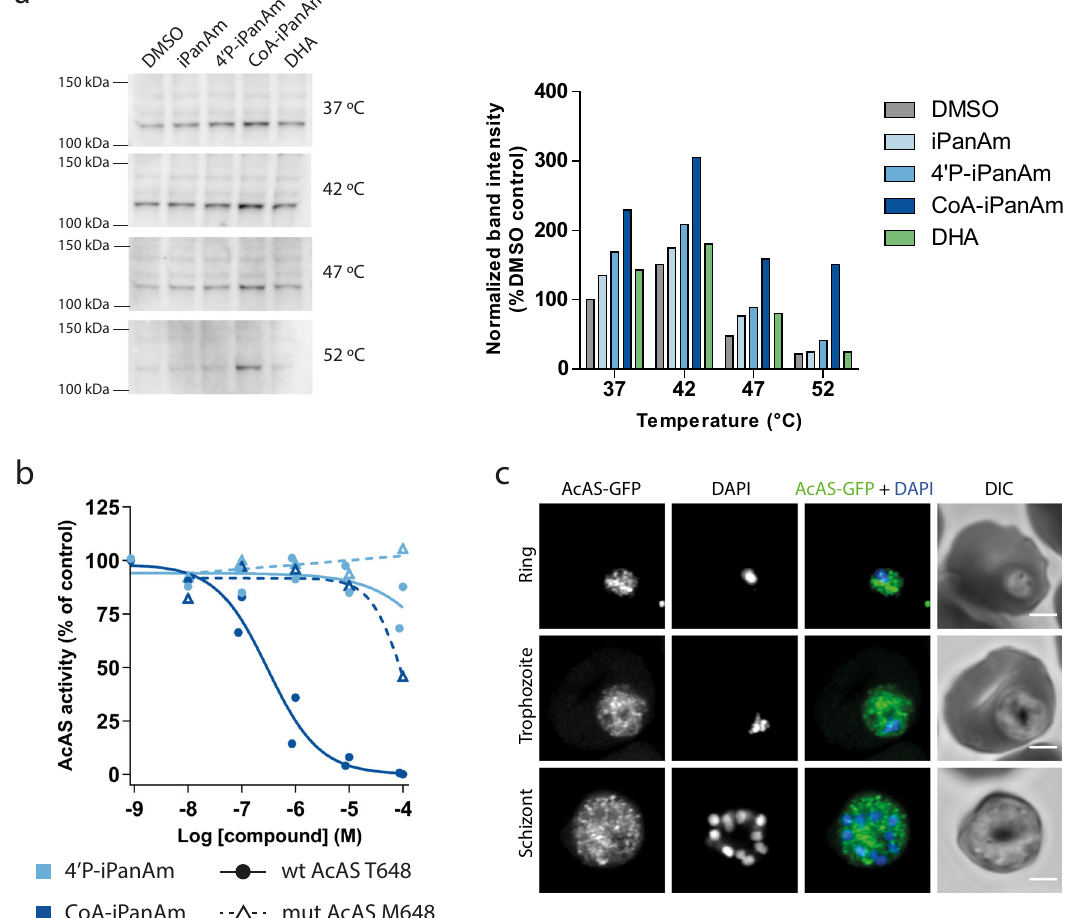
Fig. 3 CoA-PanAm binds to and inhibits AcAS. a Cellular thermal shift assay on P. falciparum lysate. Parasite lysate at 2.1 mg/ml was aliquoted and treated with 1 µ M MMV693183 or metabolites thereof, or with DHA (negative control) for 30 min, followed by a 3-min incubation at different temperatures ( N = 1). Protein stabilization was analyzed on a western blot (left panel) and band intensities (AcAS molecular weight = 113.8 kDa) were quanti fi ed and normalized to DMSO treatment at 37 °C (right panel). b , AcAS activity in a dose-response assay. Wild-type (T648) or mutant (M648) AcAS was immunopuri fi ed from NF54 or NF54-HGL and cT648M mutant parasite lysate, respectively, using rabbit immune serum. The activity was measured using 14 C-labeled sodium acetate upon treatment with metabolites of MMV693183 and normalized to the no drug control ( N = 4 for wild-type AcAS, N = 2 for mutant AcAS). c , Immuno fl uorescence microscopy of parasites with AcAS fused to GFP. Depicted are representative images of asexual blood-stage parasites stained with anti-GFP antibodies and DNA stained with DAPI. Scale bars, 2 µ m. PanAm: MMV693183; 4 ’ P-PanAm: 4 ’ P-MMV693183; CoA- PanAm: CoA-MMV693183. Source data are provided as Source Data fi